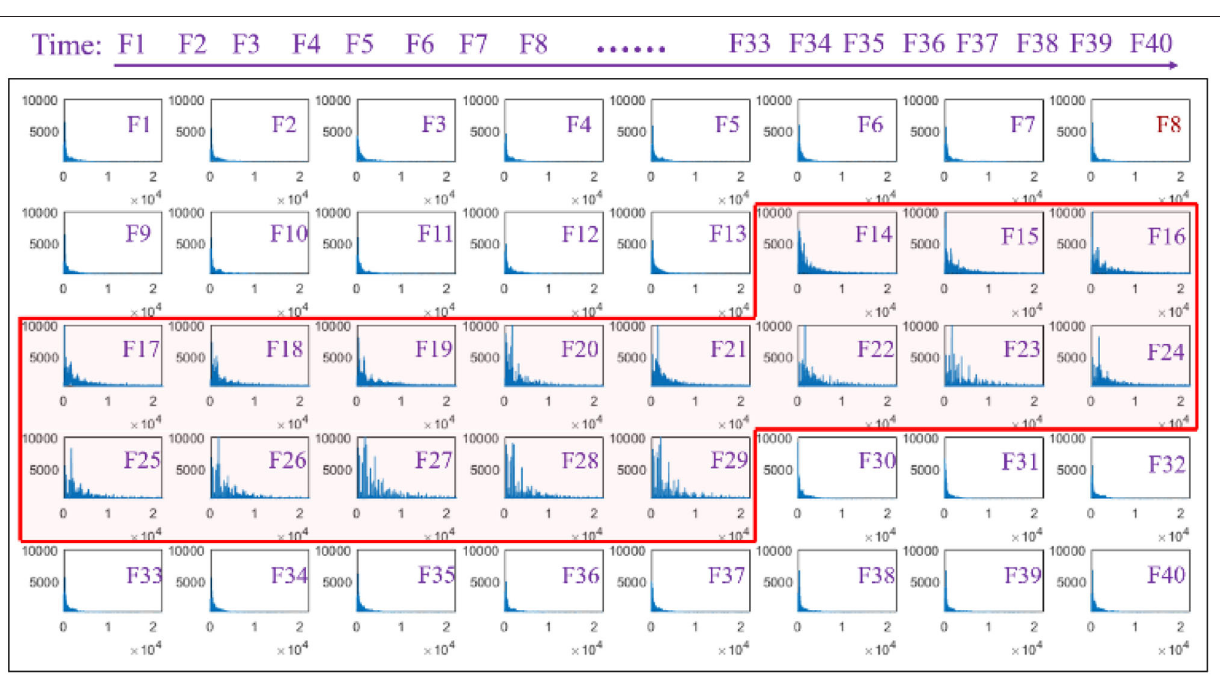
FIGURE 3 | Amplitude spectra of the speech signal with an increasing pitch from a series of analysis windows